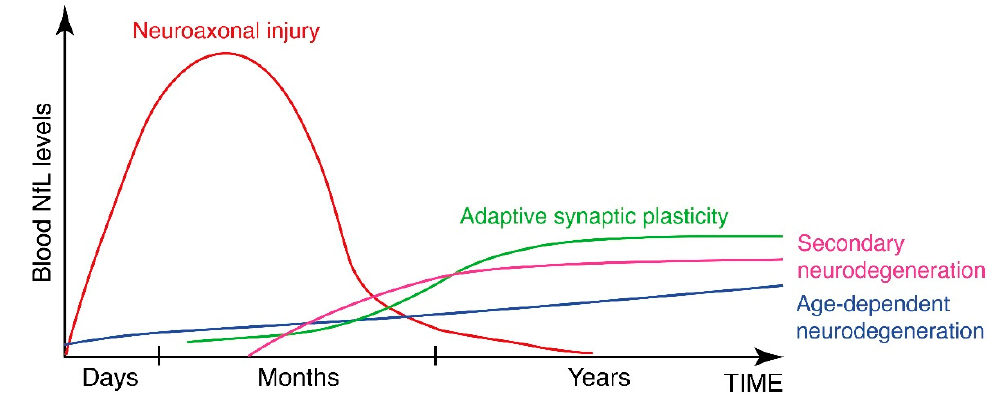
Figure 3. A model of the relative contribution of the different release mechanisms to the blood NfL levels after stroke and how they may change over time. After stroke, blood NfL levels reflect the release of NfL or NfL-derived peptides from injured axons, damaged synapses and age-dependent neurodegenerative processes as well as adaptive plasticity-related synaptic turnover. Whereas in the acute phase after stroke, the axons are the main source of blood NfL, synaptic turnover and secondary neurodegeneration are likely to be major contributors to blood NfL levels in the late phase after stroke.